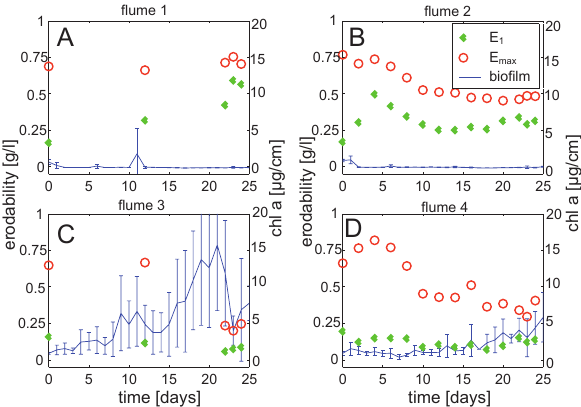
Fig. 3. Erodability ( E max and E 1 ) and chl a during the flume ex- periments. (A) Flume 1, eroded every 12 days. (B) Flume 2, eroded every other day. (C) Flume 3, eroded every 12 days. (D) Flume 4, eroded every other day. Flumes 1 and 2 were